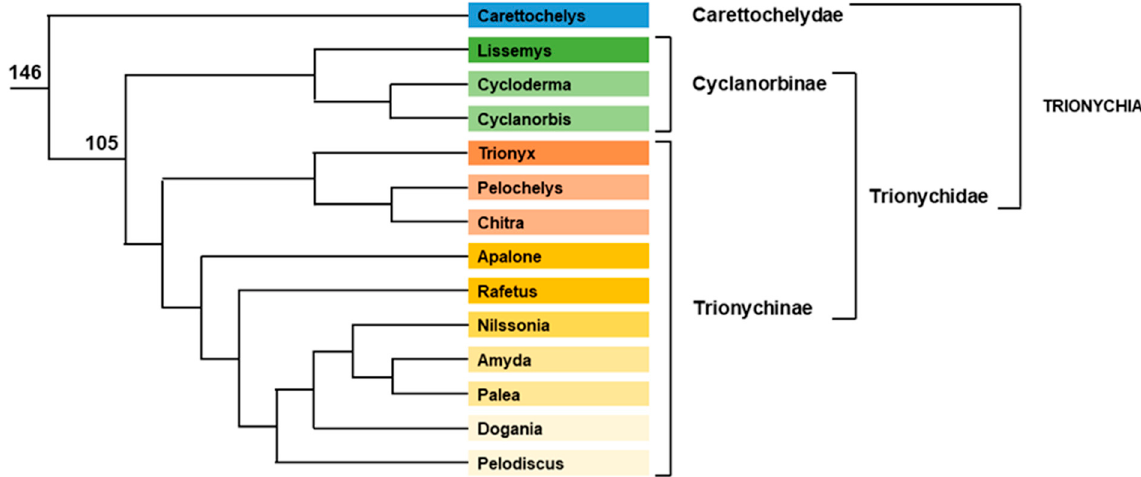
Figure 5. Phylogenic tree of trionychid turtles. Relative position of each genus and superior clade are represented. Branch lengths are not proportional to time. Numbers indicate divergence time (Myrs) from present for some key nodes, according to [39]. Color of each genus indicates the different clades.